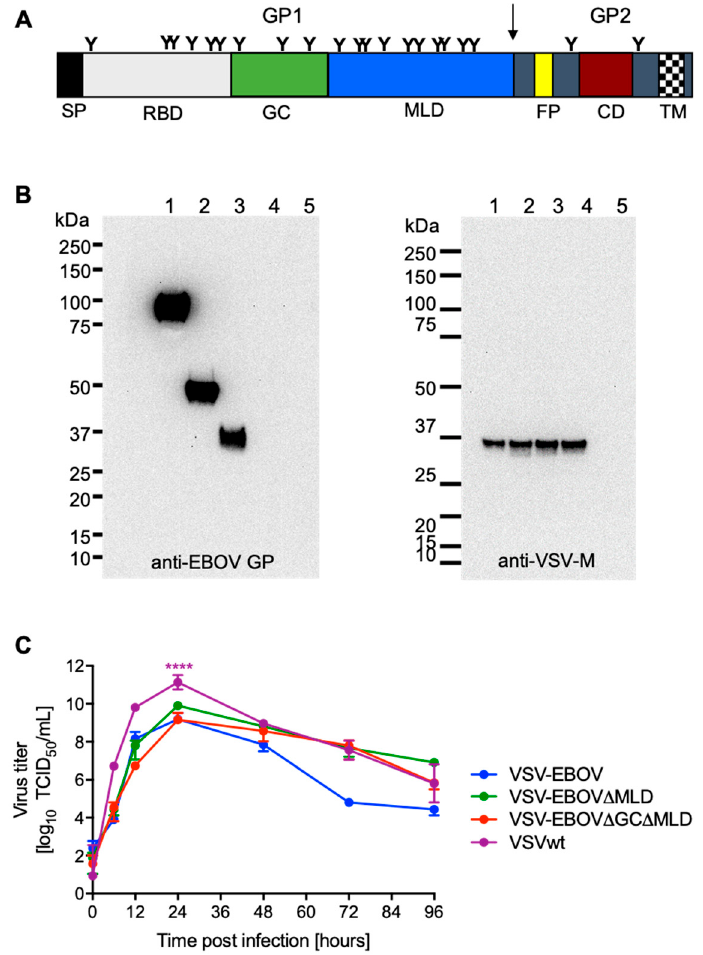
Figure 1. Vaccine construction and in vitro characterization. ( A ) Schematic of the EBOV glycoprotein (GP). SP, signal peptide; RBD, receptor-binding domain; GC, glycan cap; MLD, mucin-like domain; FP, fusion peptide; CD, coiled-coil domain; TM, transmembrane domain. Arrow indicates furin-